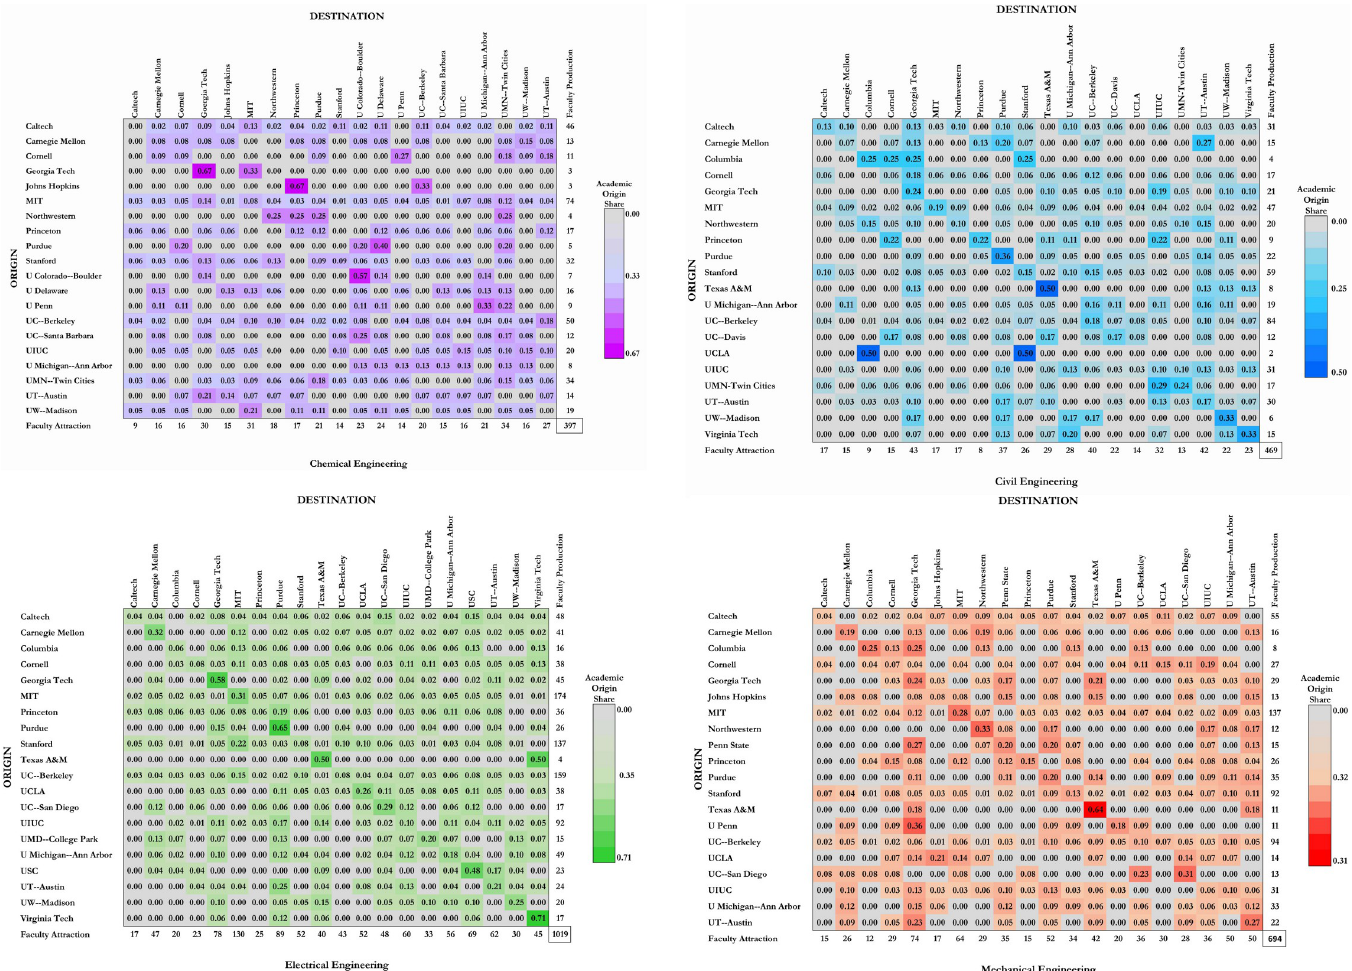
Fig 3. Origin-destination matrix of faculty graduated from top 20 and hired by top 20 ranked institutions. (A) Chemical Engineering, (B) Civil Engineering, (C) Electrical Engineering, and (D) Mechanical Engineering.